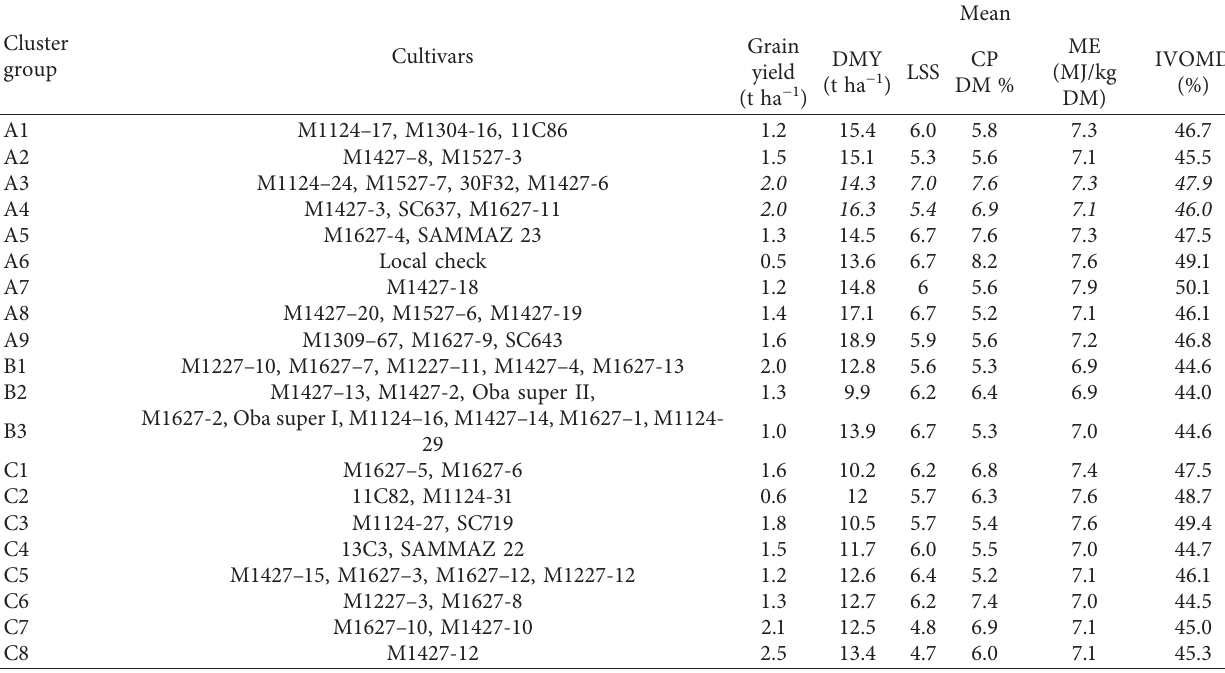
Table 6: Clustering of three-way cross DTmaize hybrids based on grain yield, dry matter yield, leaf senescence score, CP, ME, and IVOMD. Cluster Cultivars group